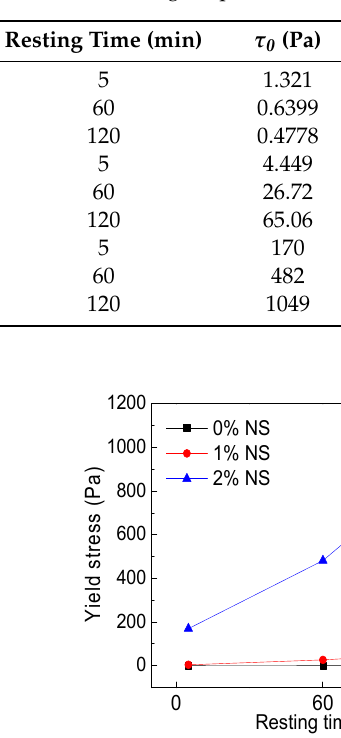
Table 5. Rheological parameters of C–FA paste with NS.